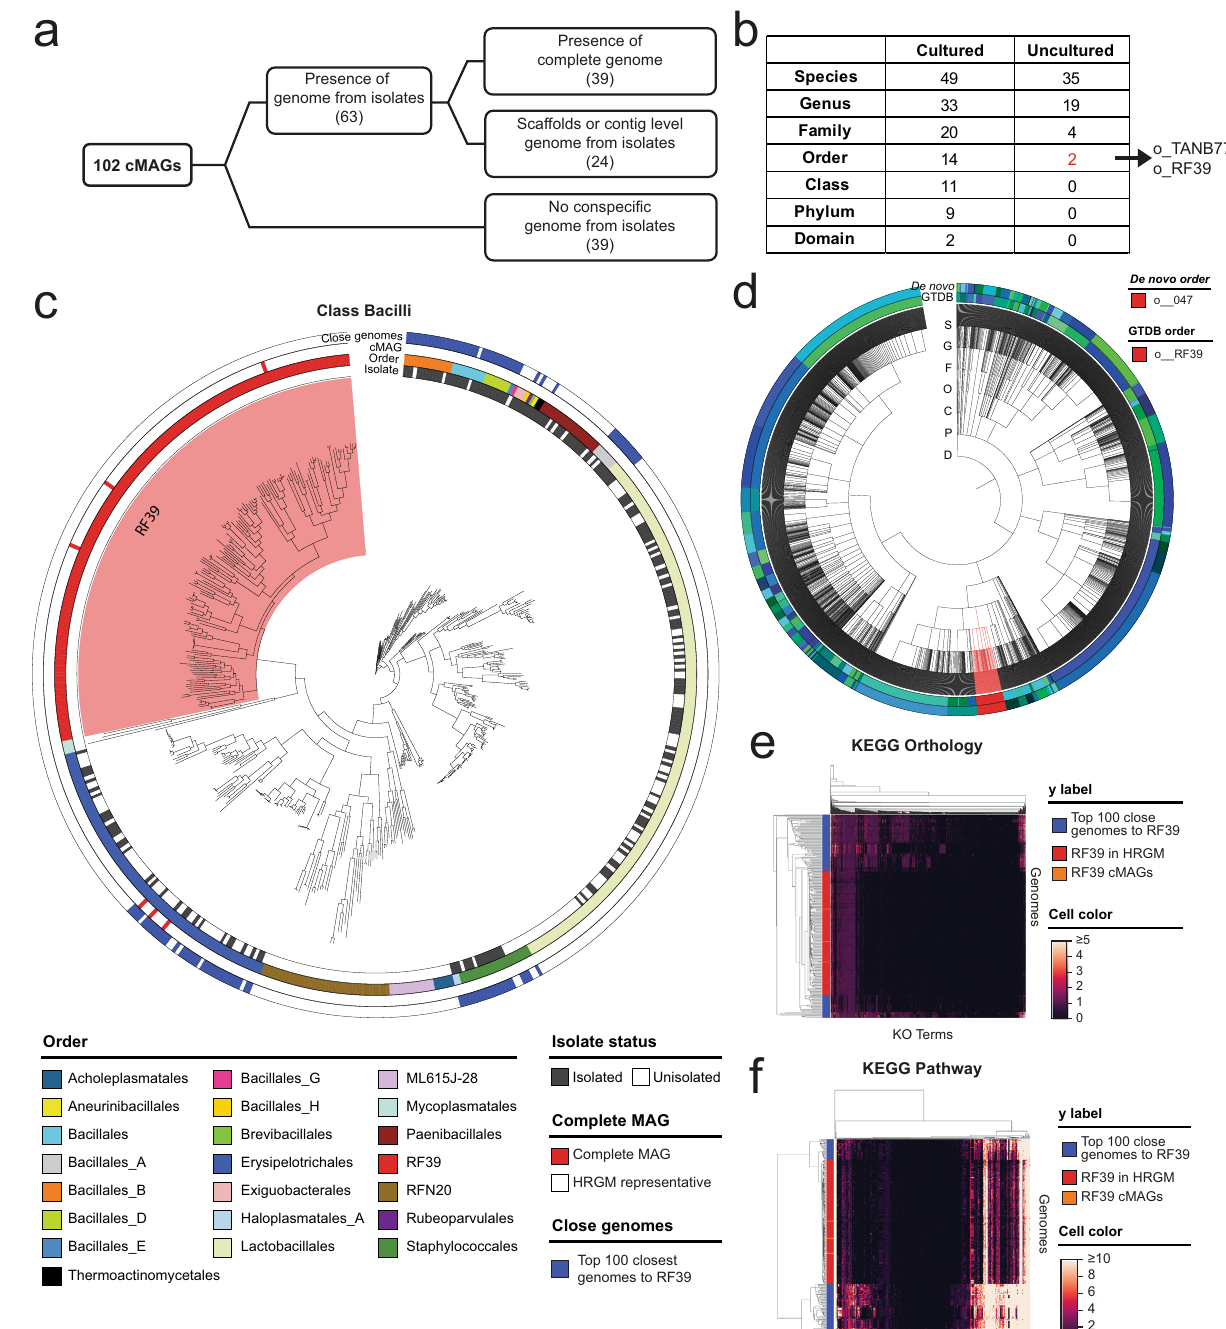
Fig. 3 | Assembly of complete genomes for uncultured microorganisms. a Number of cMAGs with isolated and complete conspeci fi c genomes. The 39 cMAGs for uncultured taxa are marked in red. b Number of cultured and unculturedtaxaamongthe102cMAGs. c Maximumlikelihoodphylogenetictree of HRGM species and HiFi cMAGs in the Bacilli class. The red-highlighted area represents the RF39 order. Isolated status, order, HiFi cMAG, and top 100 closest genomes to the RF39 order are annotated from the innermost to the